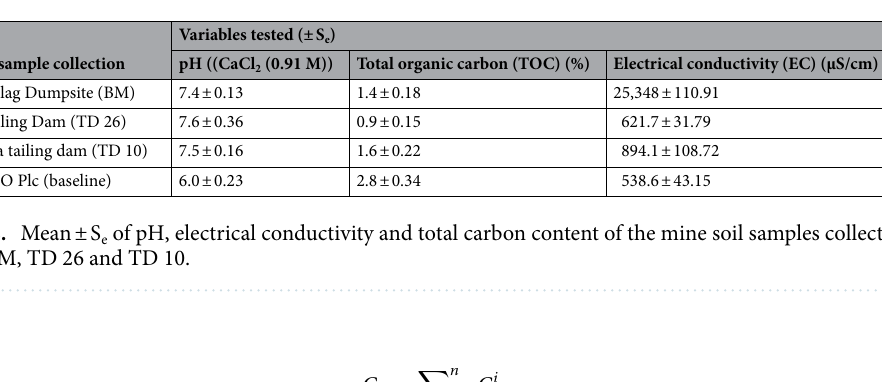
Sites of sample